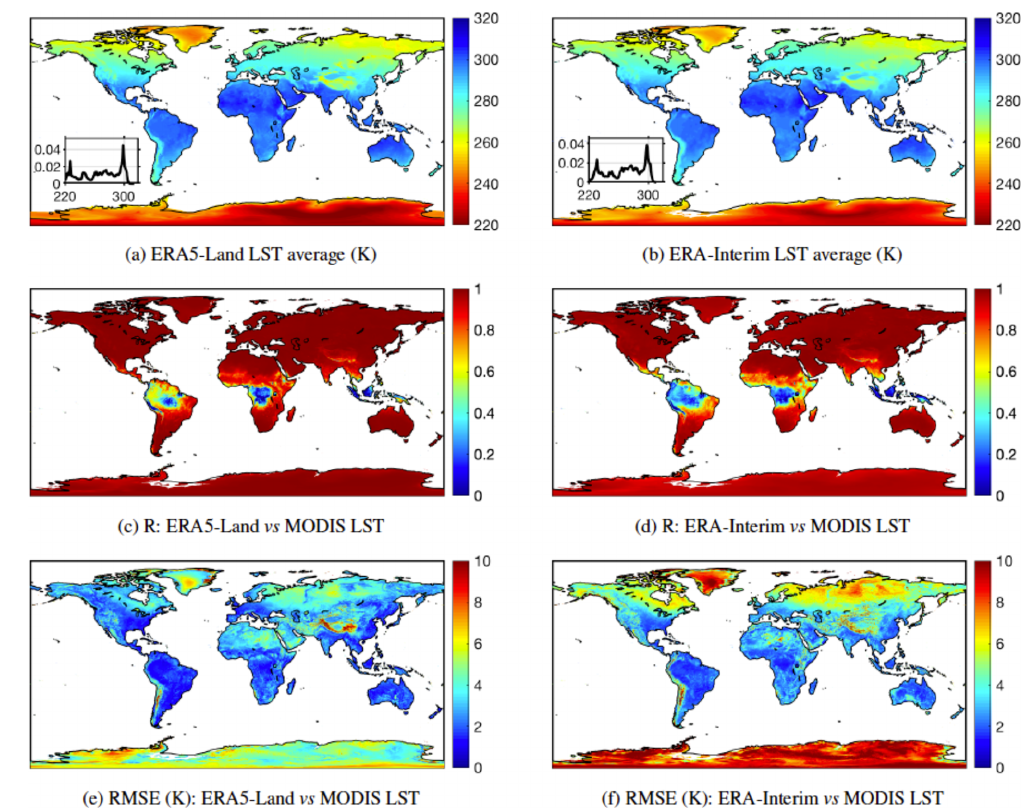
Figure 19. Global statistics of ERA5-Land (a, c, e) and ERA-Interim (b, d, f) LST (in K) for the time period 2003–2018. Panels (a) and (b) are the global maps of mean LST, (c) and (d) are the correlation maps, and (e) and (f) are the RMSE maps, with respect to the MODIS LST average ensemble. Note that the LST here refers to the skin